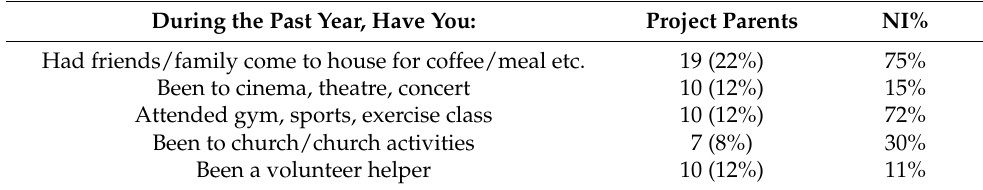
Table 1. The number of parents involved in social activities at least once a month (n = 85) compared to the NI